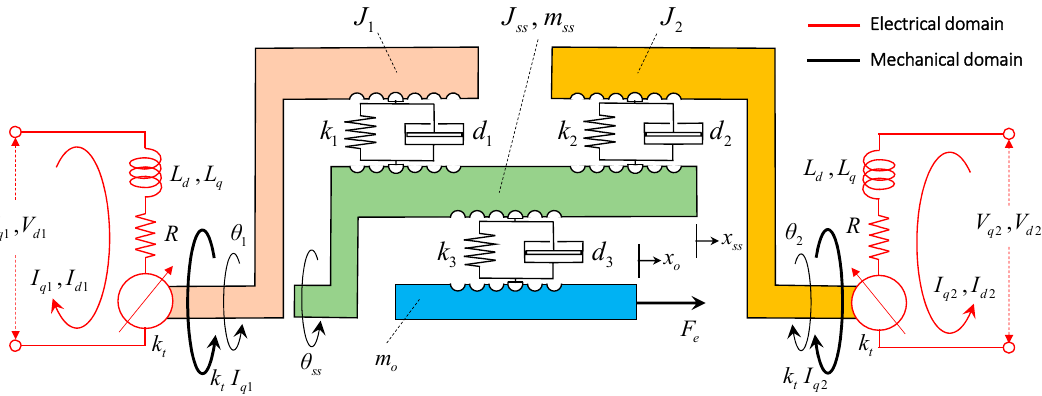
Figure 4. Schematics of the electro-mechanical section of the model. Concerning the jamming faults, they are simulated as instantaneous stops of the moving element, as described by Equation (25),